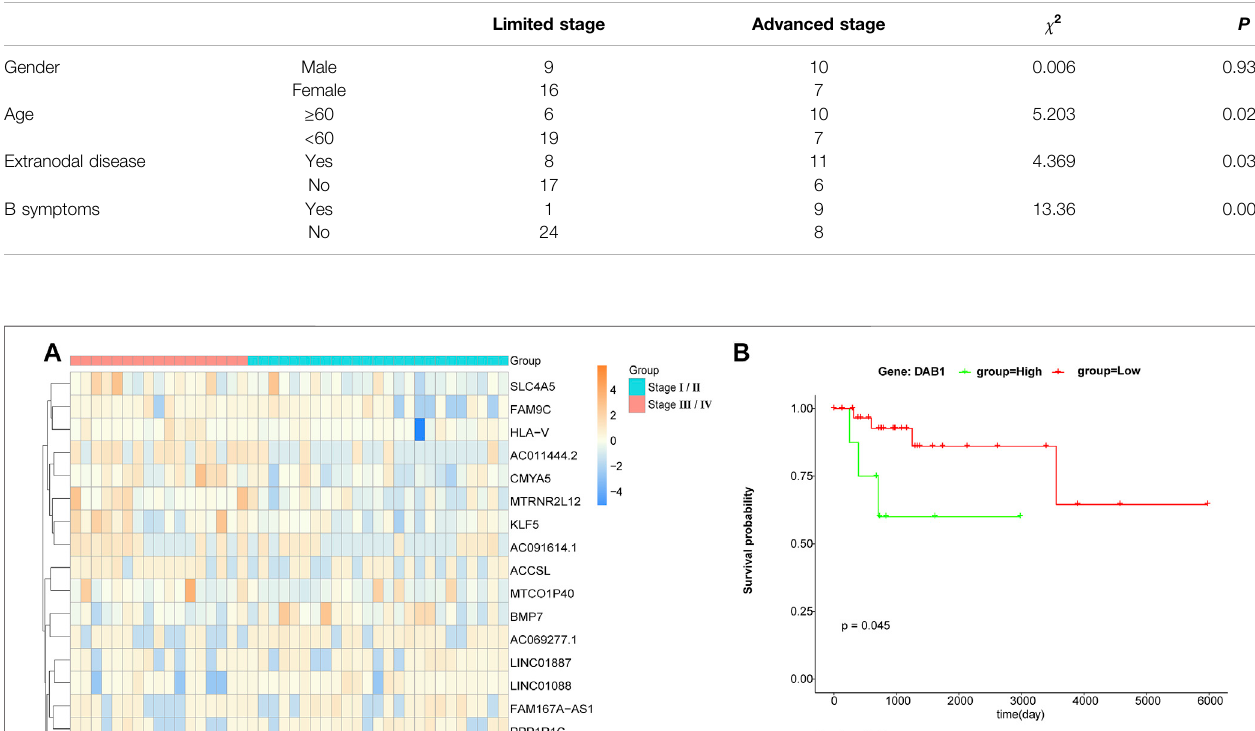
TABLE 1 | Summary of general clinical information of DLBCL cases in TCGA.